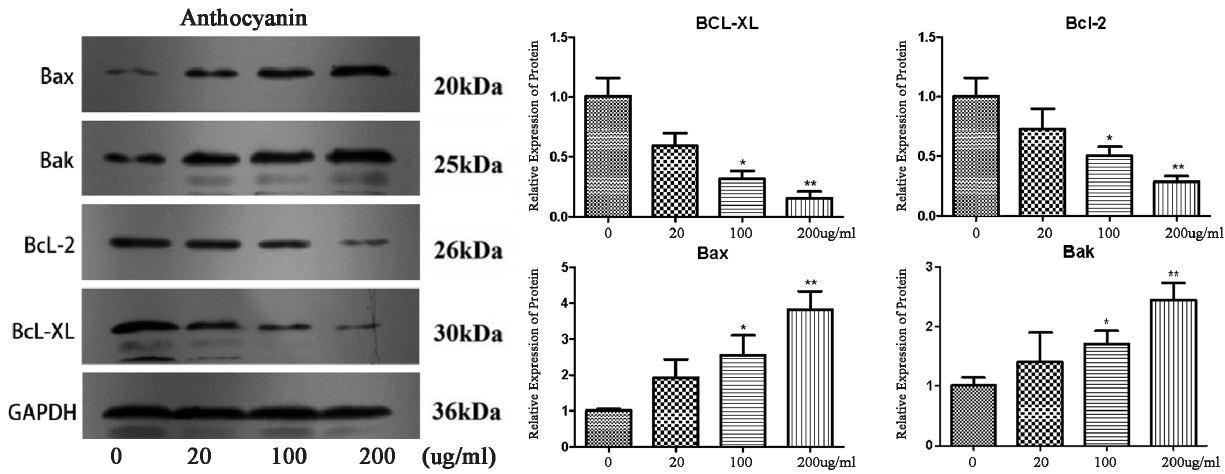
Figure 8. Expression levels of apoptosis-related proteins (Bax, Bak, Bcl-2, and Bcl-xl) by western blotting. GAPDH was treated as a control. The results are expressed as the mean ± SD ( n = 3). Different asterisks indicate a significant difference at p <